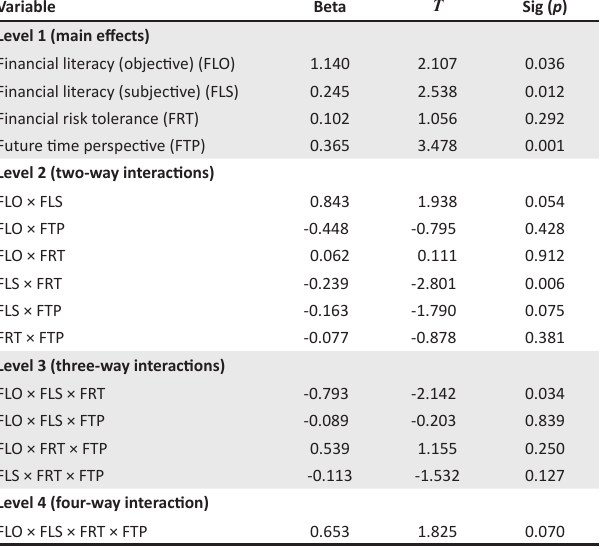
TABLE 7: Hierarchical regression analysis of perceived retirement adequacy for full sample. Variable